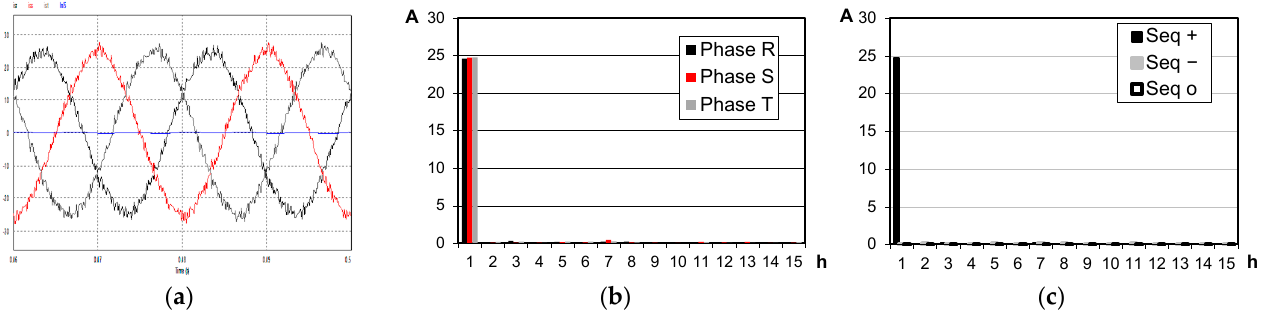
Figure 19. Case G—( a ) supply currents (phases R , S , and T and neutral); ( b ) harmonic spectrum of phase components; ( c ) harmonic spectrum of the symmetric components.